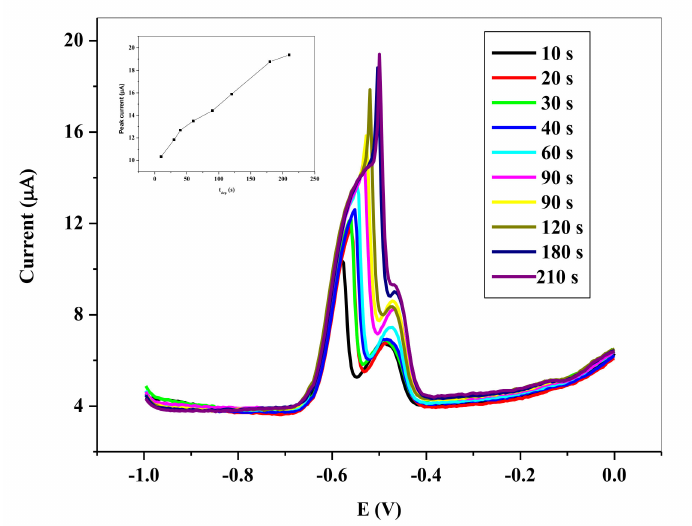
Figure 11. SWVs showing impact of deposition times on the stripping peak current of 6.0 × 10 − 5 M Pb 2+ in 0.1 M HCl electrolyte on SPCE/OPE/BIONPs/PANI, 1100 mV deposition potential, 30 s deposition time, (Potential vs. Ag/AgCl).